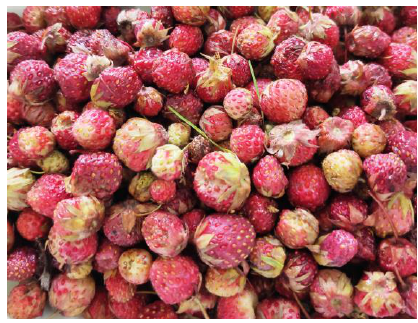
Figure 1. Fragaria viridis Weston (creamy strawberry).